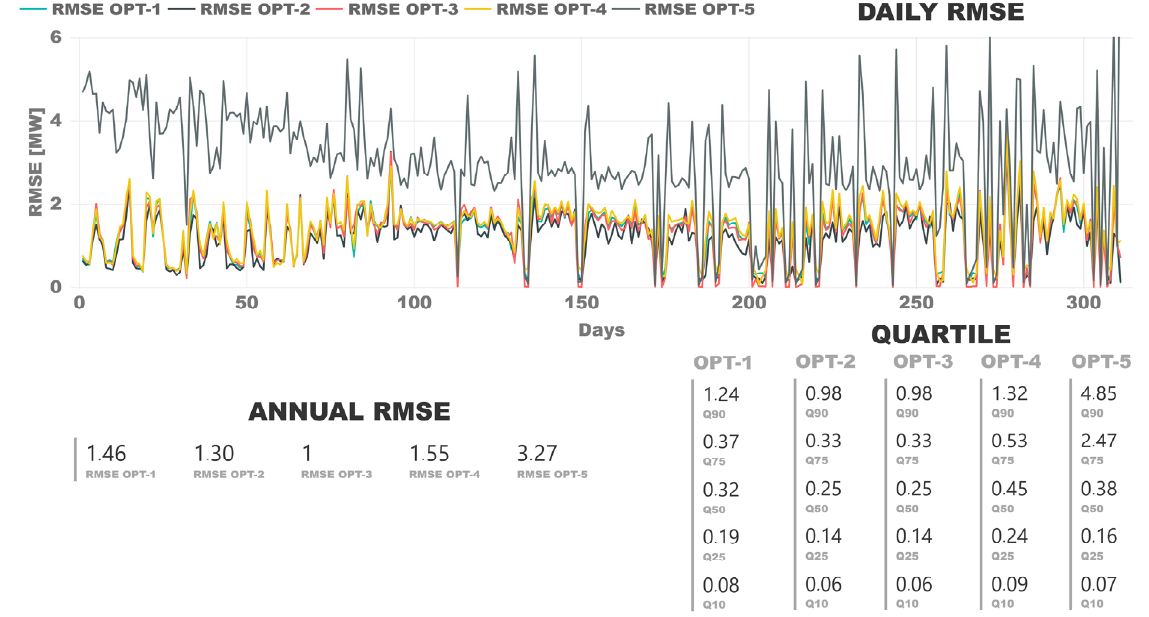
Figure 3. Comparison of model RMSE with validation data.